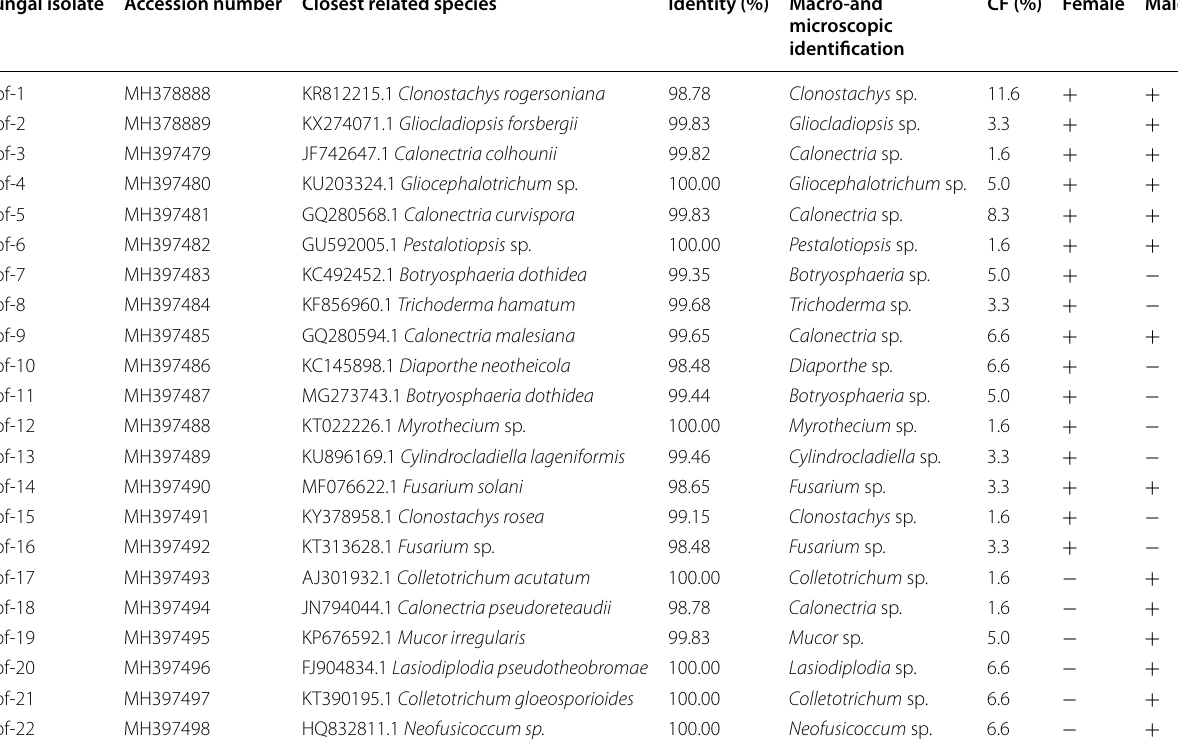
Table 1 Colonization frequency (CF) of the endophytic fungi isolated from B. polyandra and their closest relatives based on the data from the BLASTn analysis Fungal isolate Accession number Closest related